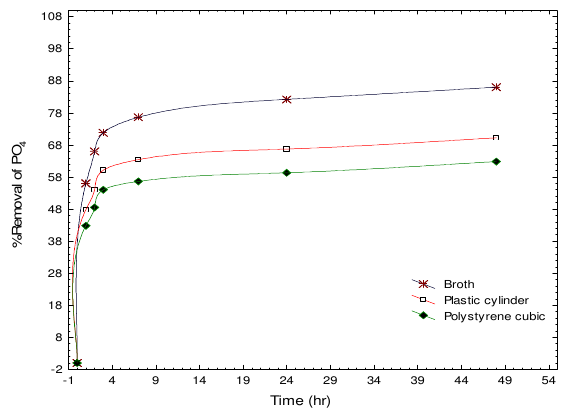
Fig. 21. Effect of Packing type on the Removal percent of PO 4 pollutant with time at T=25 o C, pH7, wastewater/ (Algae packing) ratio =1, and sterilized wastewater.